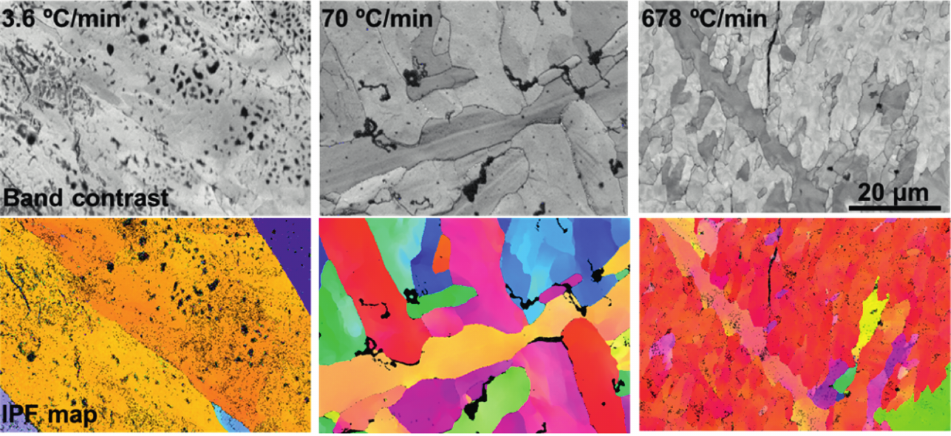
Figure 19: EBSD analysis of steel with Ti 2 O 3 addition at different cooling rates